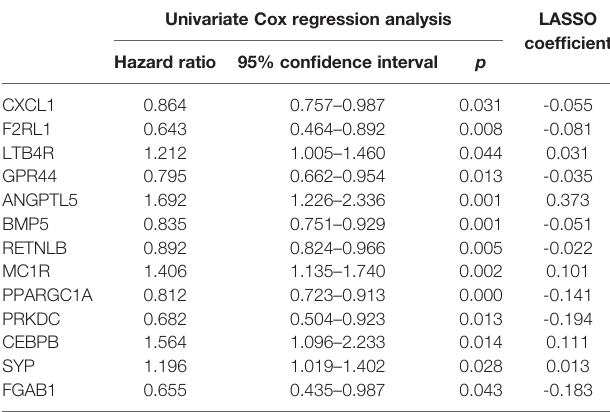
TABLE 2 | Immune-related genes in the prognostic classi fi er associated with overall survival in the gene set enrichment dataset. Univariate Cox regression analysis